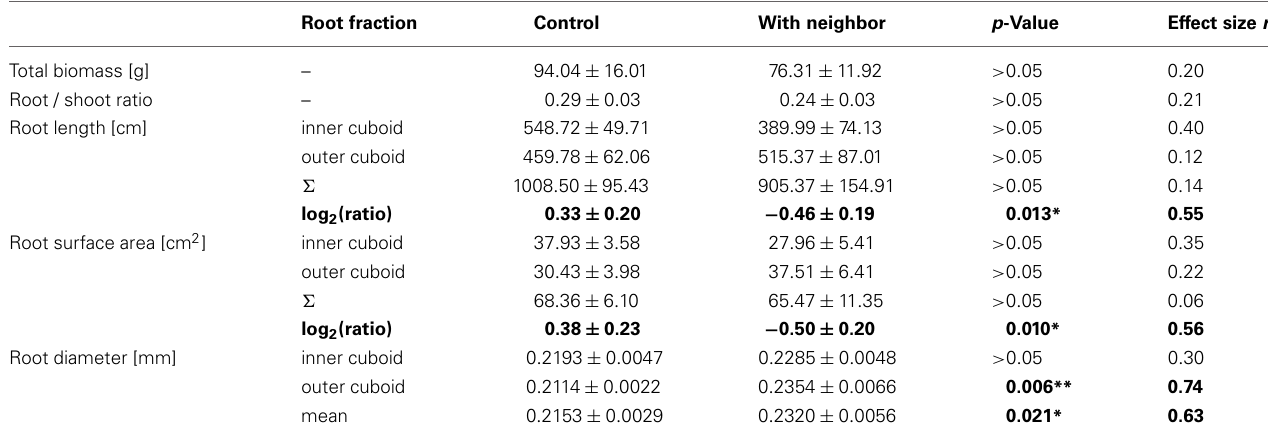
Table 1 | Biomass and root morphological traits (means ± SE) of A. thaliana in control ( n = 11) and neighbor contact treatment ( n = 9). Root fraction Control With neighbor p